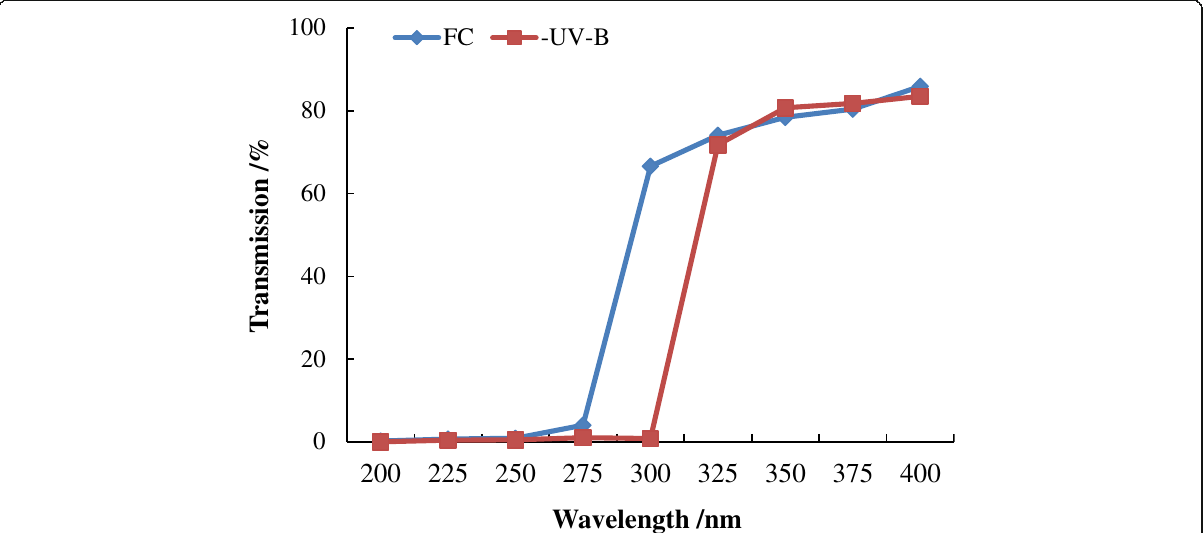
Fig. 1 Transmission spectra of UV-B cut-off filters used for UV-B exclusion and polythene filters used for filter control (FC) for raising cotton plants var. Vikram under field